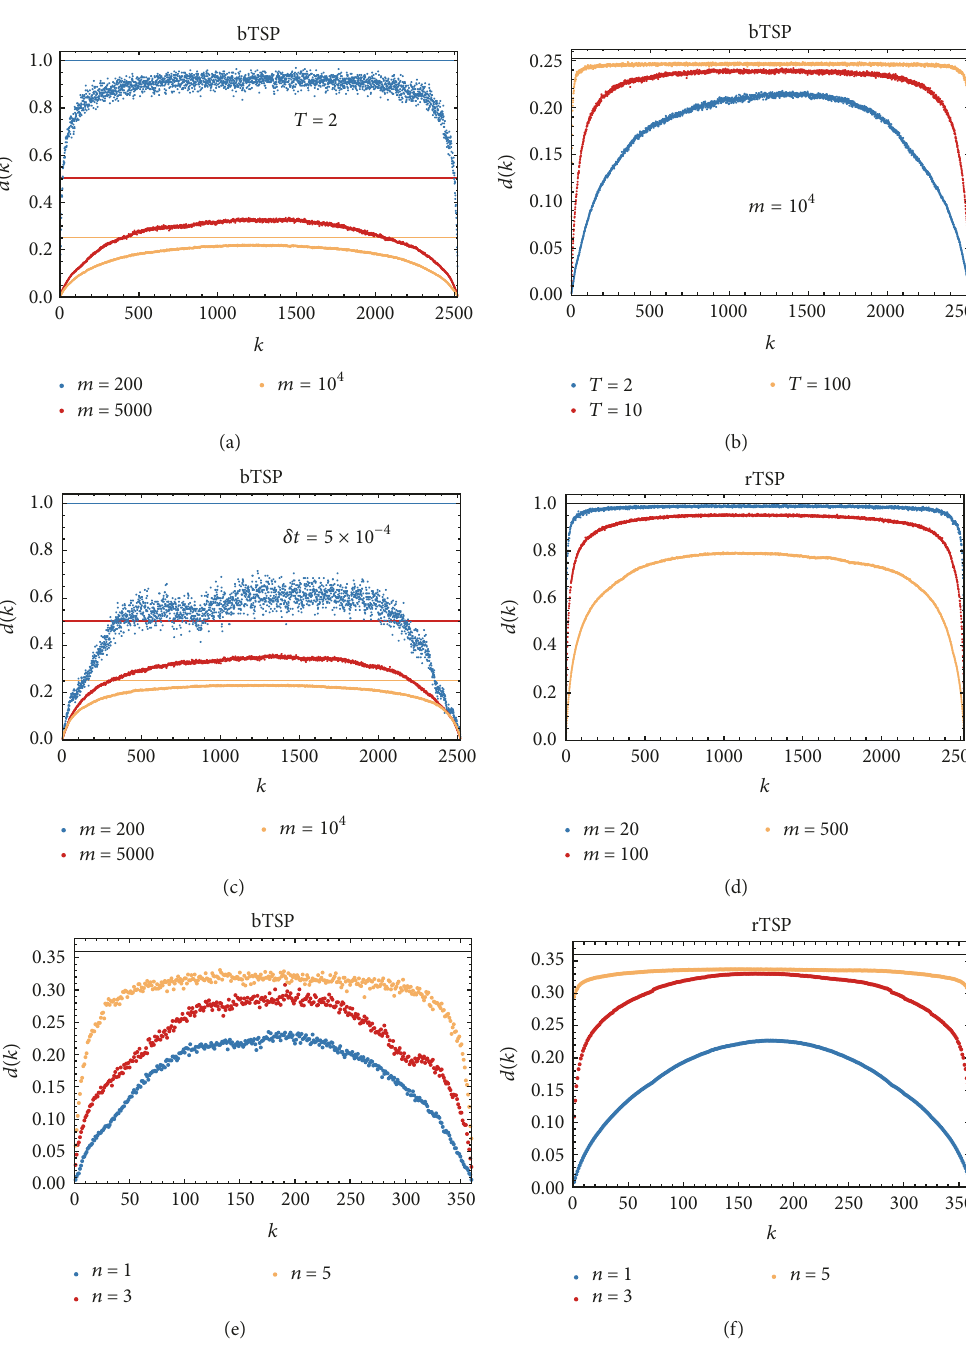
Figure3: Parameterdependenceofrankdiversity .Weanalyzehowchangingparametervaluesaffectstherankdiversityfortwotime-dependent versions of the TSP. For panels (a)–(d) we consider 𝑁 = 8 . Starting with the bTSP and 𝑛 = 𝑁 , we (a) vary the number of observations 𝑚 while keeping the total time 𝑇 = 2 , (b) fix the number of time steps 𝑚 = 10 4 while varying the total time, and (c) fix the value of 𝛿𝑡 = 5×10 −4 while changing the number of time steps (and thus the total time). For the rTSP, we also (d) show how changing the number of time steps alters the diversity. Curves are averages over 100 realizations. Panels (e) and (f), respectively, show the rank diversity for the bTSP when 𝑛 sites are allowed to move and for the rTSP when 𝑛 sites are reallocated at each time step, with both 𝑁 = 7 and 𝑚 = 1000 . For the bTSP the total time is 𝑇 = 10 , which leads to 𝛿𝑡 = 0.1 . We choose this value of 𝑇 so that the ranges of the diversity in (e) and (f) resemble each other. Results in (f) are averages over 1000 realizations. Horizontal lines correspond to 𝑑 max , the maximum value of the diversity given in (1). In (b), (d), (e), and (f) all curves have the same bound, whereas in (a) and (c) color is used to indicate the bounds of each